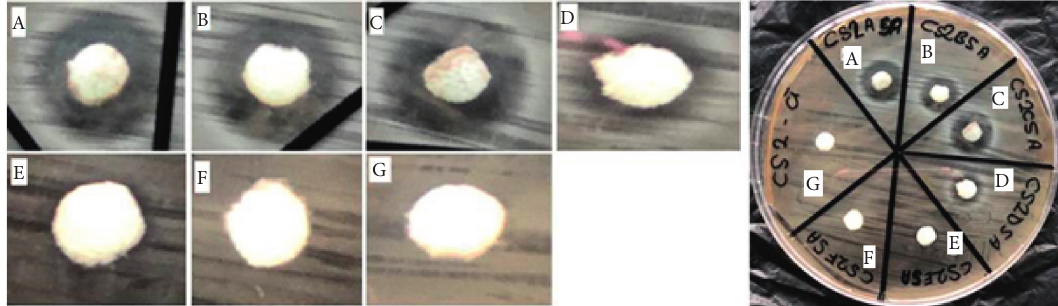
Figure 12: Antibacterial activity of CuO/Ag nanocomposite against S . aureus . The paper disks were impregnated with the following suspension of copper oxide nanoparticles: A � 5mg/ml, B � 2 mg/ml, C � 1 mg/ml, D � 0.5 mg/ml, E � 0.25mg/ml, F � 0.1mg/ml, and G � 0mg/ml.